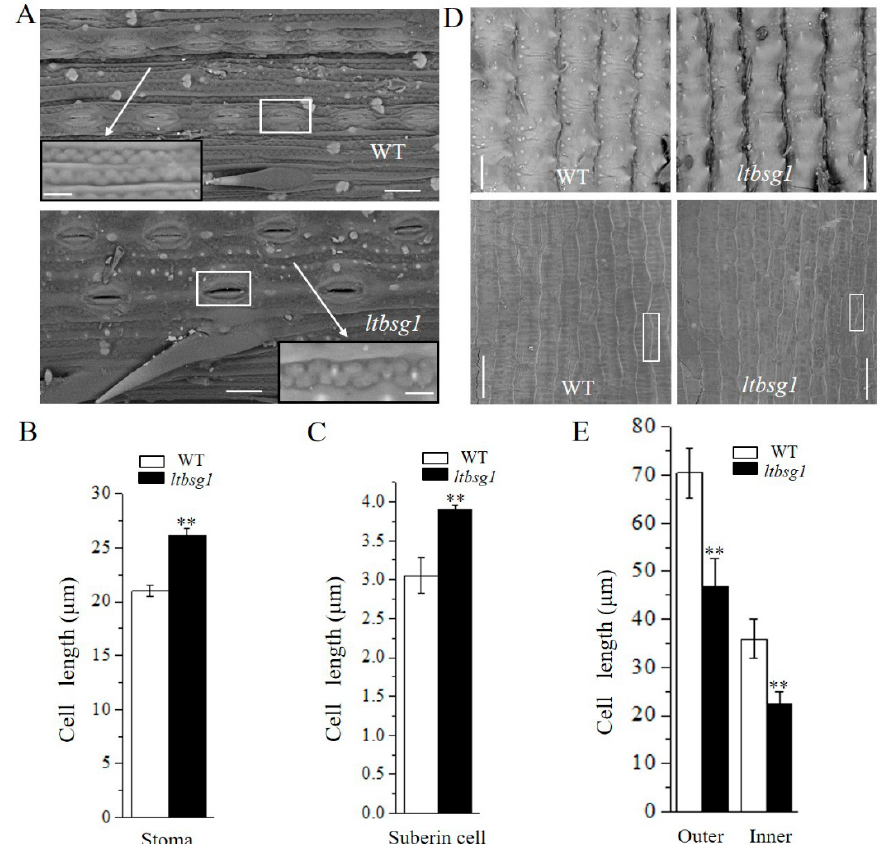
Figure 2. The effect of LTBSG1 on top branch and grain development. ( A ) The scanning electron microscopic analysis of the top branch surfaces of WT and mutant ltbsg1 . Bars = 20 µ m. The white frames indicated the stoma and the white arrows indicated the magnified views of suberin cell. Bars = 5 µ m; ( B ) The length of stoma in top branch surfaces of WT and mutant ltbsg1 ; ( C ) The length of suberin cell in top branch surfaces of WT and mutant ltbsg1 ; ( D ) The scanning electron microscopic analysis of spikelet hulls of WT and mutant ltbsg1 . The outer surface and inner surface were showed up panel (Bars = 50 µ m) and bottom panel (Bars = 30 µ m), respectively; ( E ) The cell length of outer and inner surfaces of spikelet hulls in WT and mutant ltbsg1 . Values represent the means ± SD ( n = 10). ** p < 0.01.